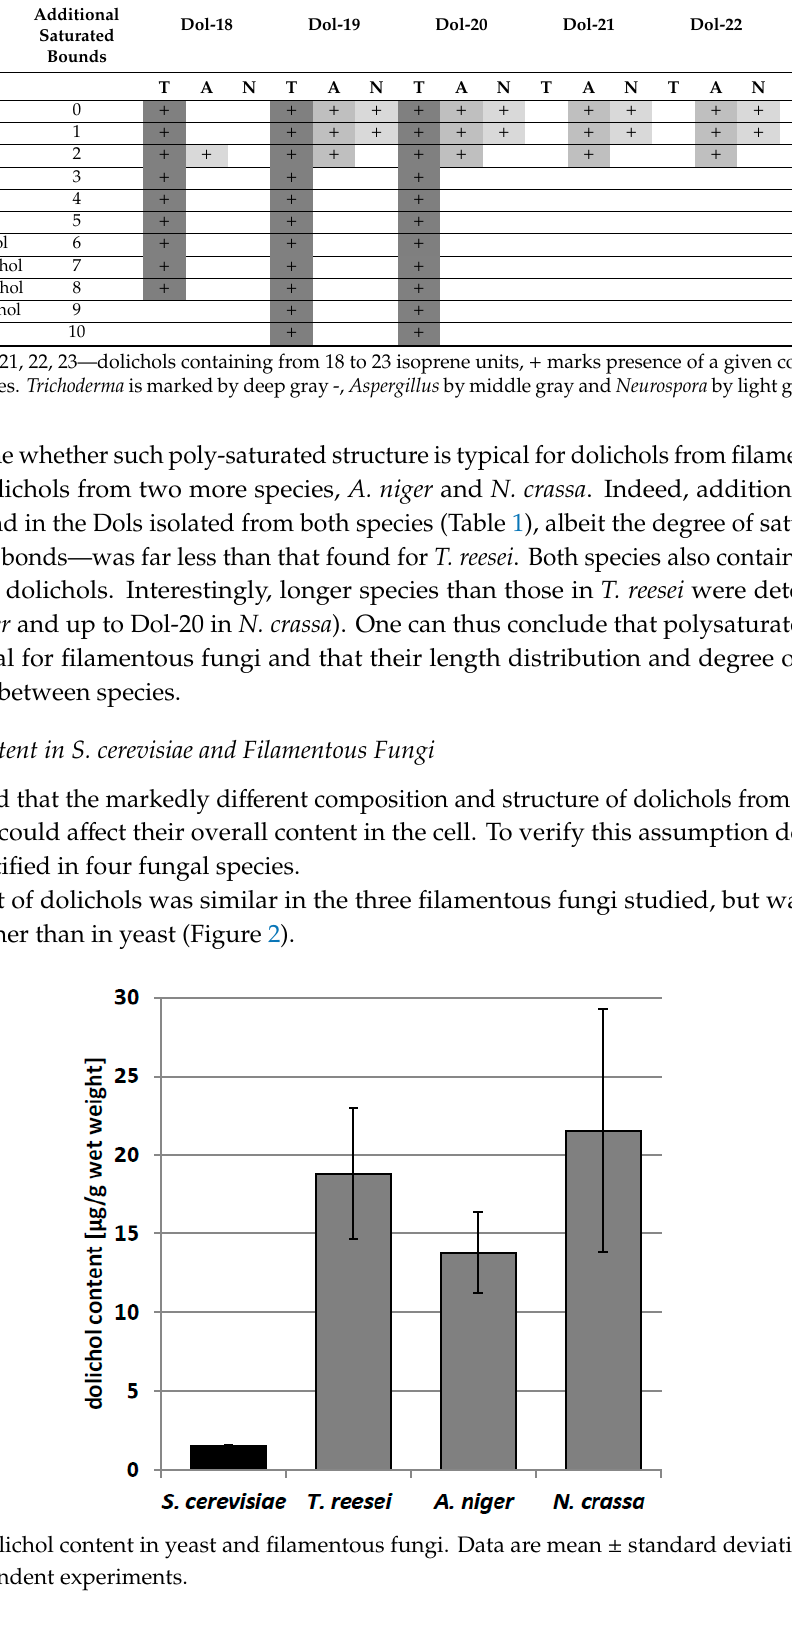
Table 1. Dolichols found in filamentous fungi, Trichoderma reesei (T) Aspergillus niger (A) and Neurospora crassa (N). No of Additional Dolichol Species Dol-18 Dol-19 Dol-20 Dol-21 Dol-22 Saturated Bounds